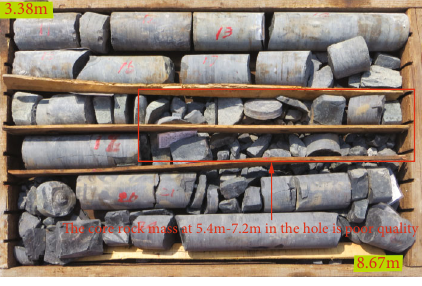
Figure 4: Site core